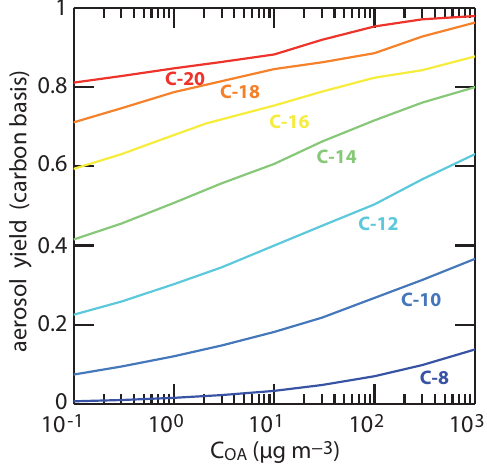
Fig. 5. Maximum carbon based aerosol yields simulated for the n - alkane series as a function of C OA Figure 5: Maximum carbon based aerosol yields simulated for the n ‐ alkane series as a function of C OA .